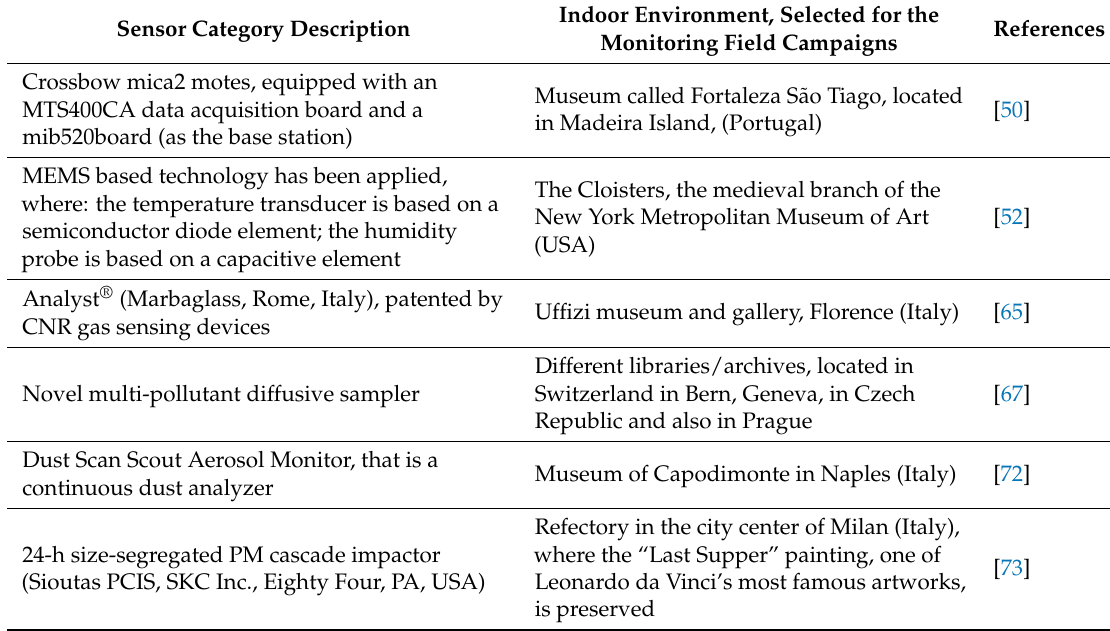
Table 3. Summary of the most important monitoring field campaigns, organized in several famous national and international museums, libraries and galleries, discussed in the